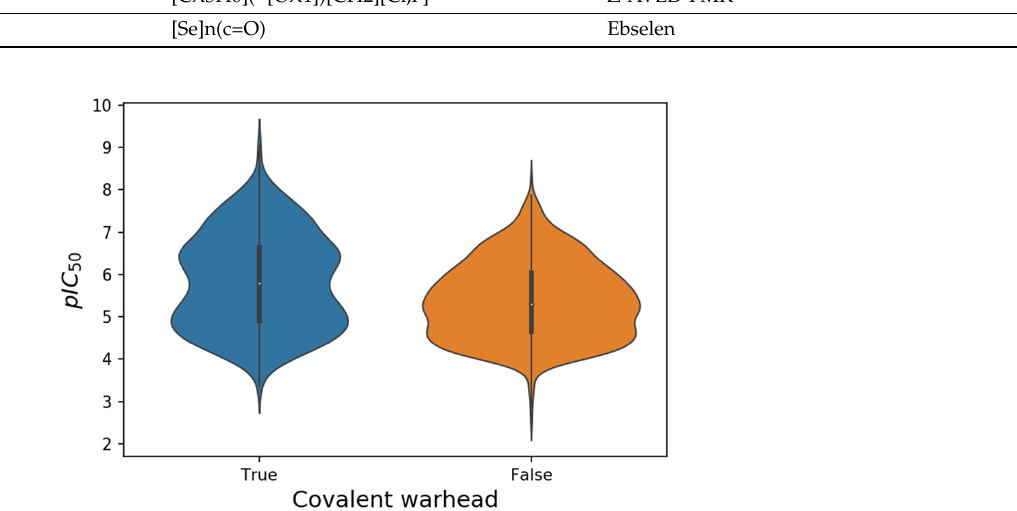
Figure 2. Violin plots of the pIC 50 values from 552 putative covalent and 1213 non-covalent SARS- CoV-2 M-pro inhibitors.